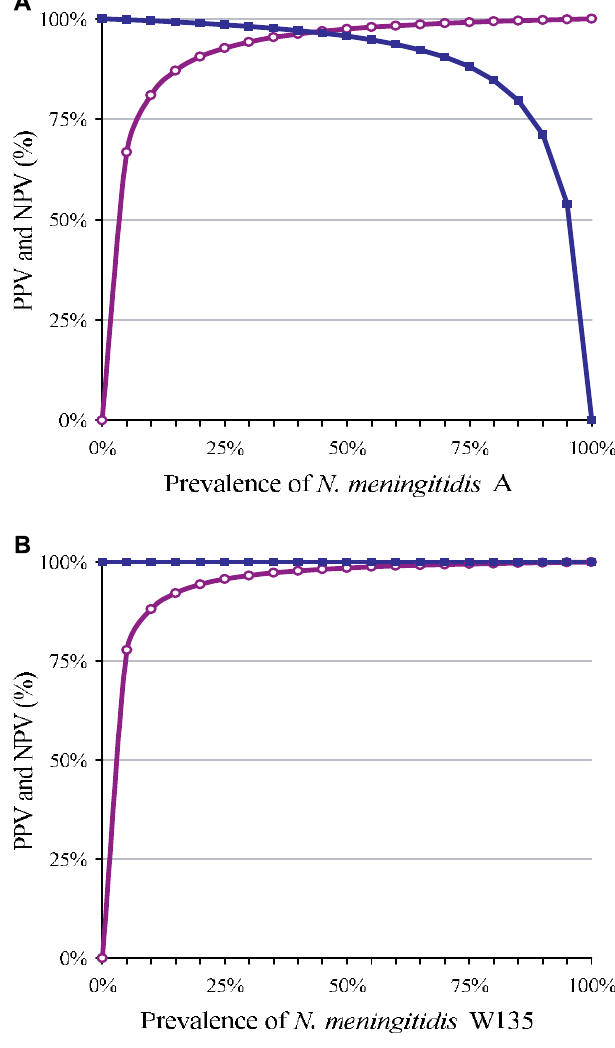
Figure 2. Predictive Values for N. meningitidis Diagnosis PVPs and NPVs for the diagnosis of N. meningitidis serogroup A (A) and serogroup W135 (B), according to prevalence. PVP is represented by the purple line with open circles, and NPV by the blue line with filled circles. DOI: